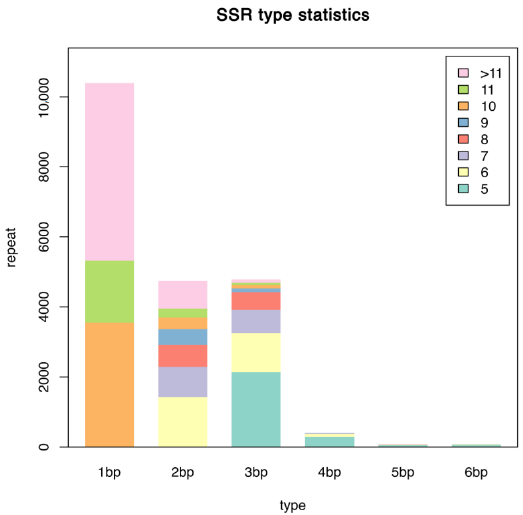
Figure 3. SSR type statistics chart.